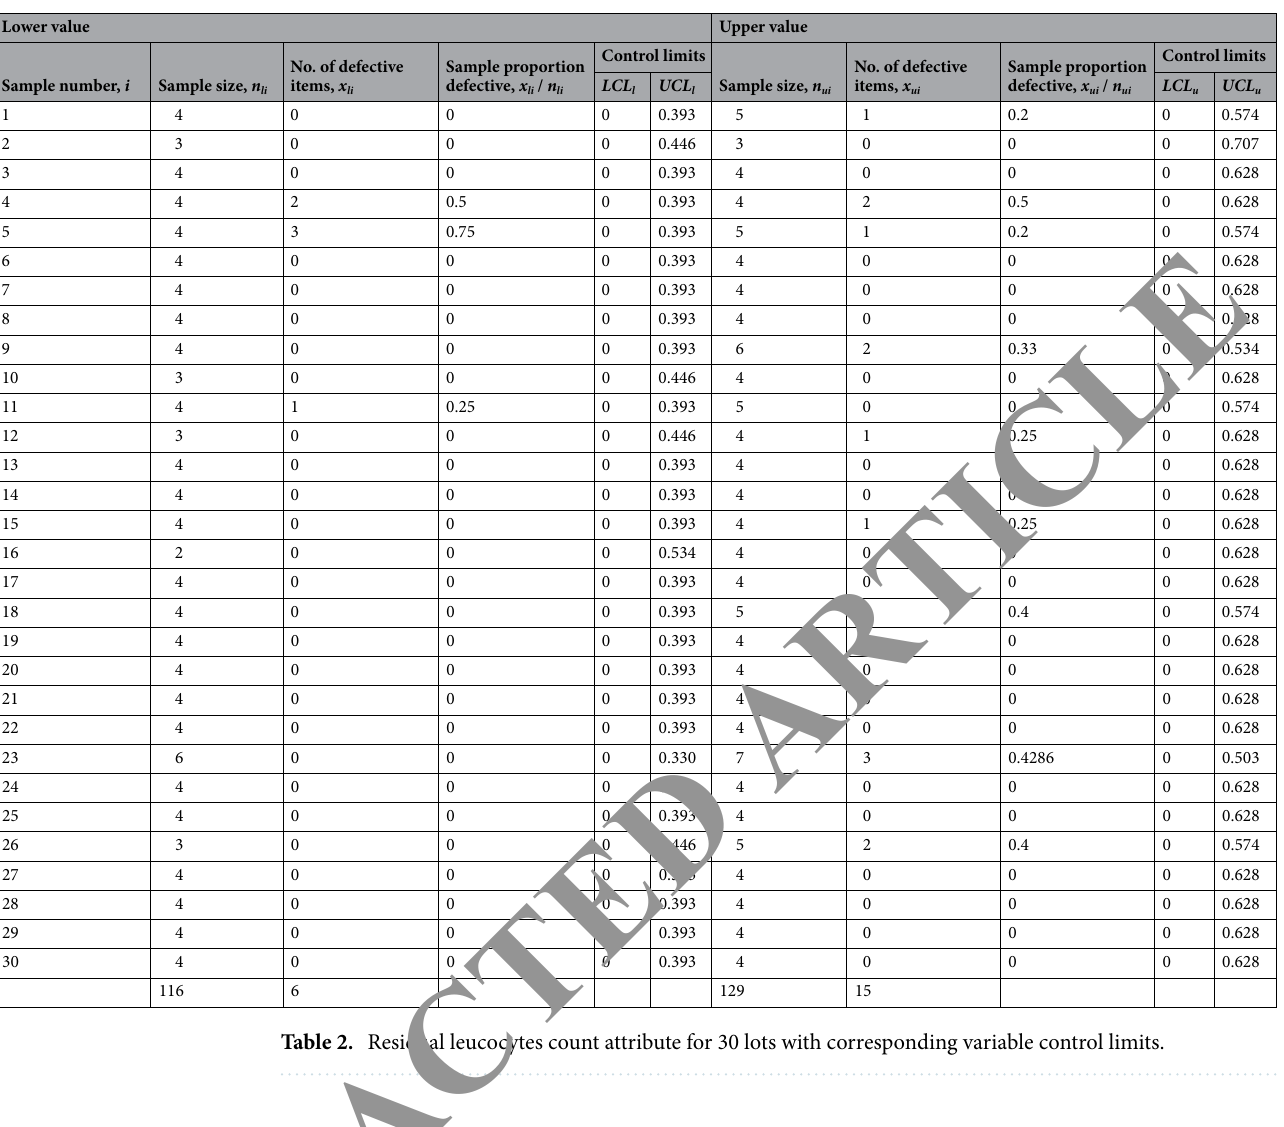
Table 2. Residual leucocytes count attribute for 30 lots with corresponding variable control